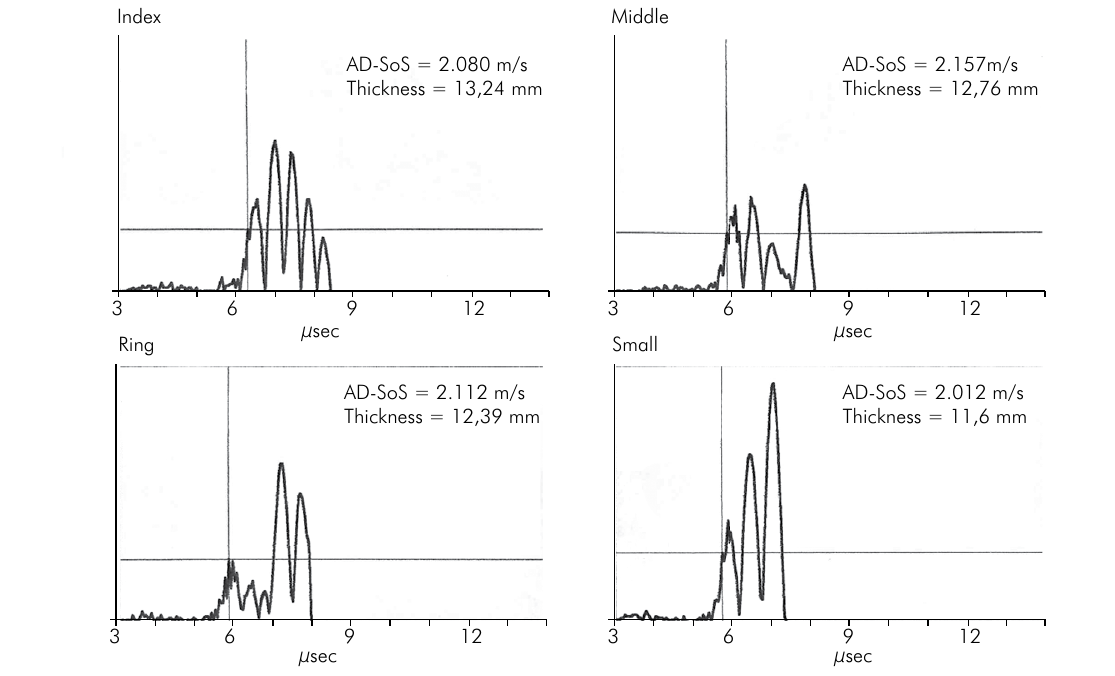
Figure 2. Biophysical bone profile of a BRONJ patient without bone exposure: most of the pulses showed attenuation and inversion. The value of AD-SoS between 1.949 m/s and 2.040 m/s classifies the patient as having low bone quantity; patient presents risk of osteoporotic